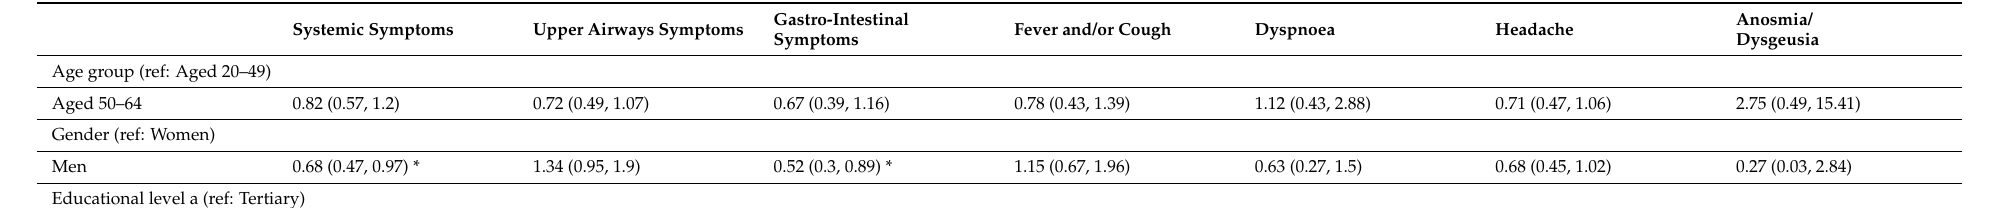
Table A9. Prevalence ratios (95% confidence intervals) from Poisson regressions estimating likelihoods of reporting COVID-19 symptoms at follow-up (January– February 2021), Ticino (N =